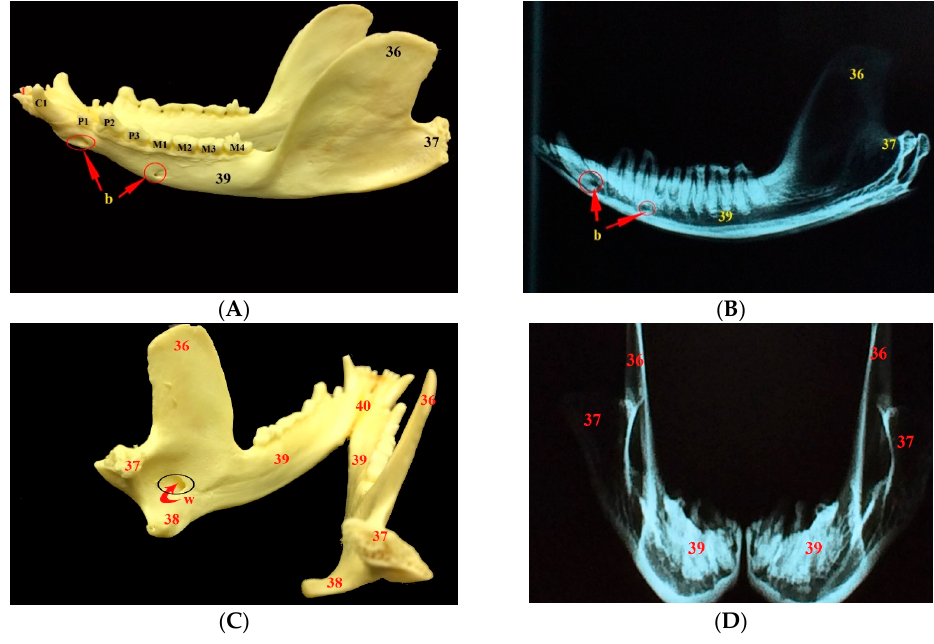
Figure 7. Images showing gross anatomy ( A ) and radiography ( B ) of the lateral view as well as gross anatomy ( C ) and radiography ( D ) of the caudal view of the mandible of the common opossum. 36. coronoid process; 37. condylar process; 38. angular process; 39. ramus of the mandible; 40. body of the mandible; 41. prearticular process; b. mental foramina; w. mandibular foramen; I. lower incisor teeth; C1. lower canine teeth; P1–3. lower premolar teeth; and, M1–4. lower molar teeth.